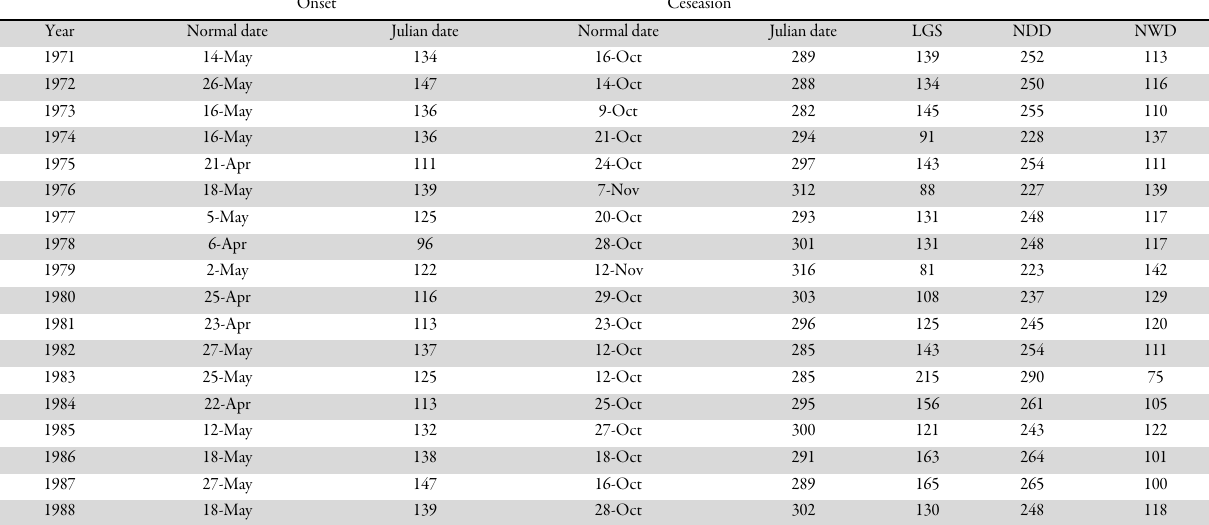
Table 4. Onset, cessation, length of growing season (LGS), number of dry days (NDD) and number of wet days (NWD) in Yola